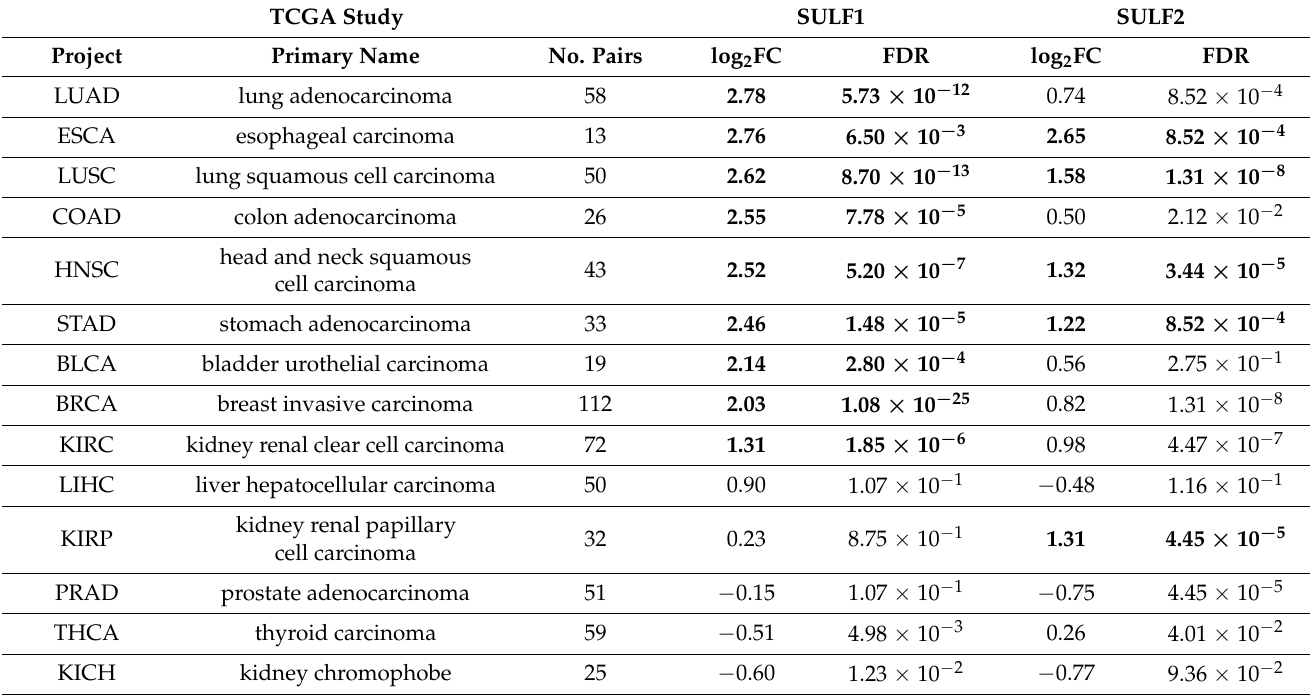
Table 1. Differential expression of SULF1 and SULF2 mRNA between paired tumor and normal tissues in 14 TCGA studies. Entries with fold-change > 2 and FDR < 0.05 are in bold. TCGA Study SULF1 SULF2